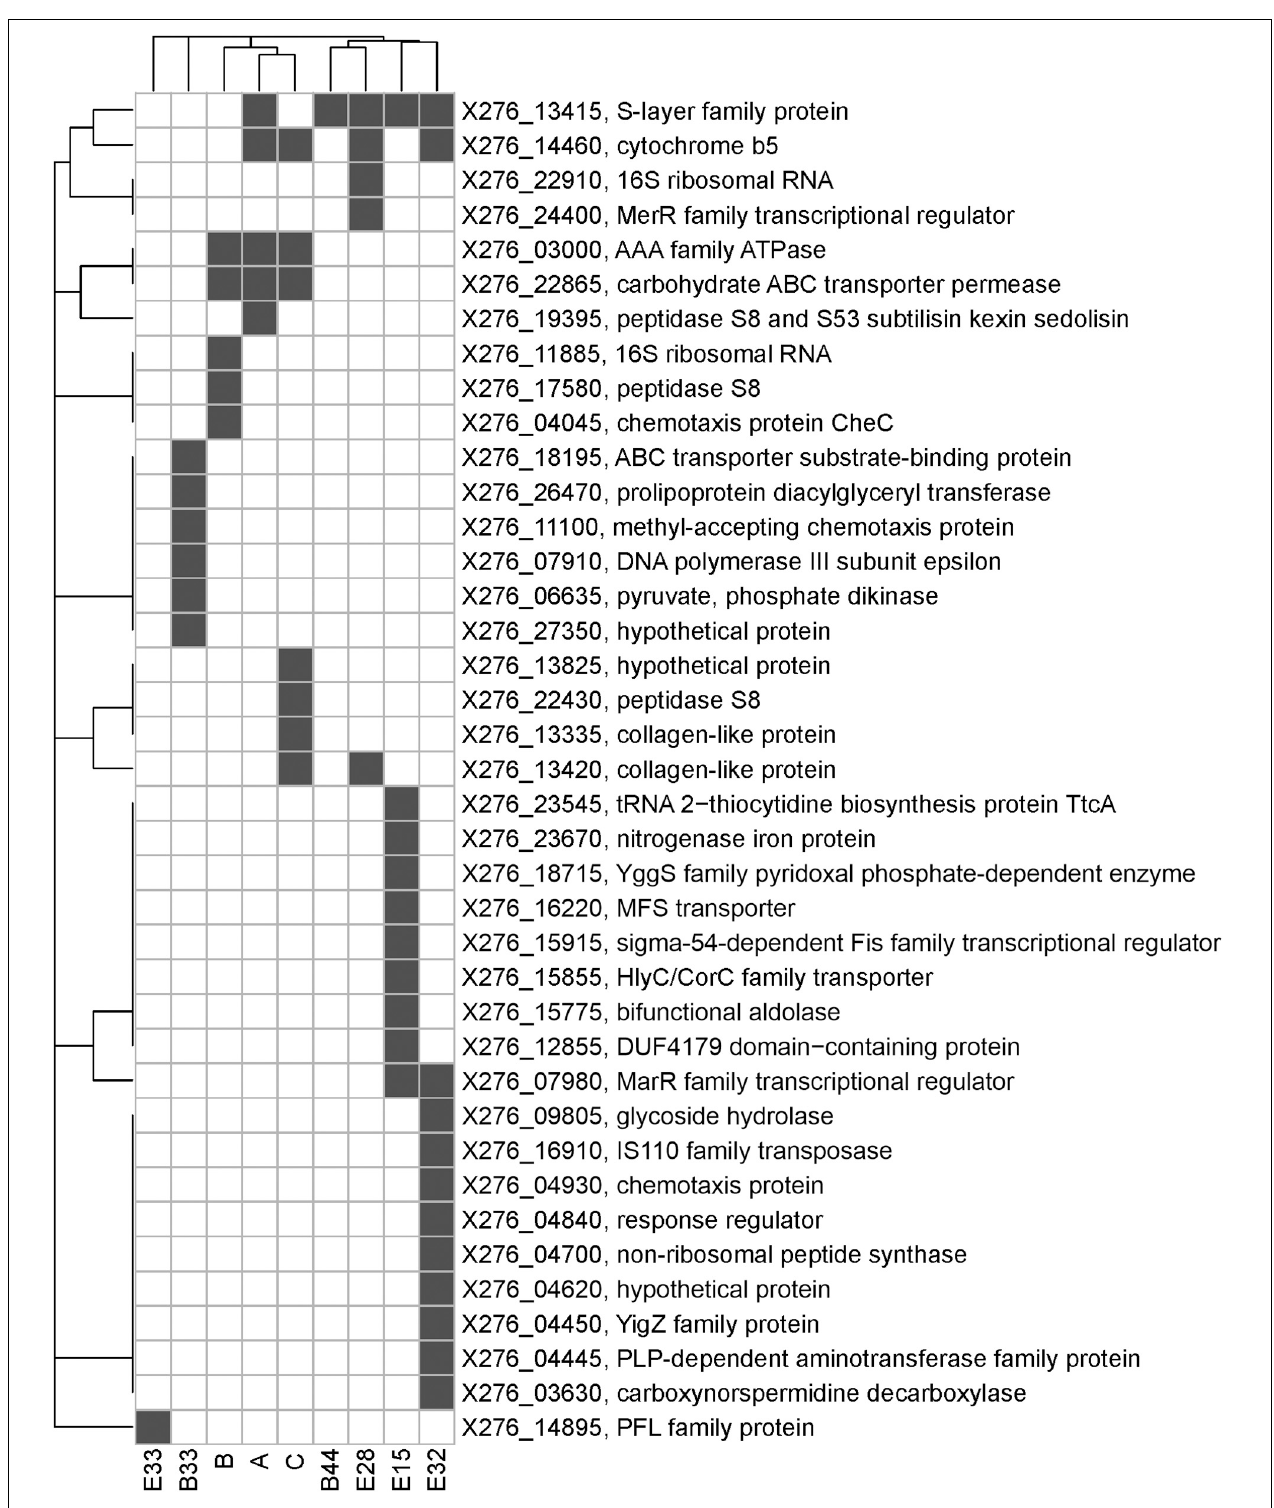
FIGURE 5 | A bi-clustered binary heatmap showing the distribution of genes with single-nucleotide polymorphisms among mutant strains of C. beijerinckii NRRL B-598 with improved butanol tolerance. Complete linkage clustering is based on binary distance between genes and mutants, respectively. Strains A, B, and C were obtained by random chemical mutagenesis using EB as a mutagenic agent, when strains were selected directly on agar plates containing EB; Strains B33 and B44 were obtained by random chemical mutagenesis using EMS with selection on butanol; strains E15, E28, E32, and E33 were obtained by random chemical mutagenesis using EMS with selection on